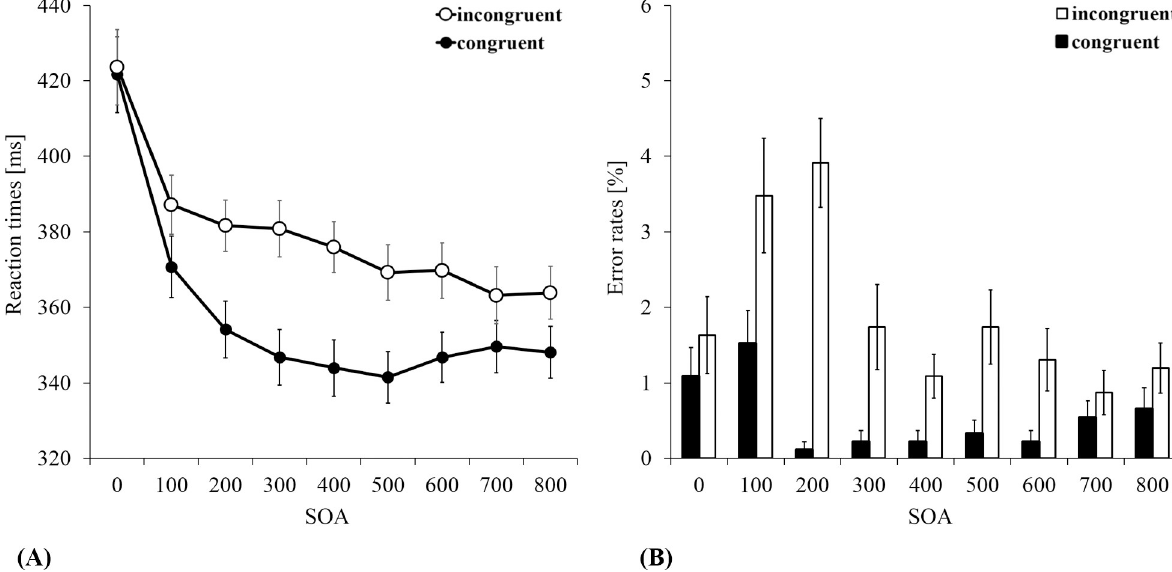
Fig 3. Results. Mean reaction times ± SE (A) and mean error rates ± SE (B) for the pass without a head fake (blank circles/columns) and the pass with a head fake (black circles/columns) as a function of SOA.